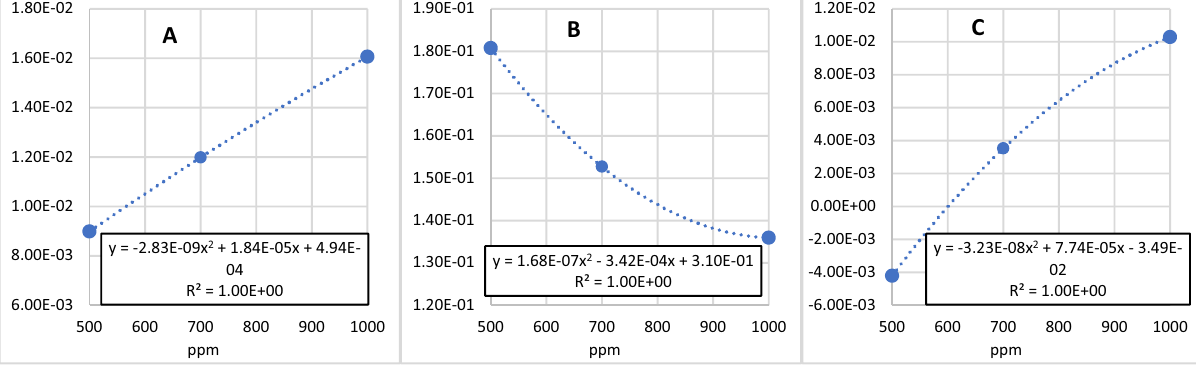
Fig. 14 Relation between the parameters A , B and C of Eq. 8 and the concentration of HPAM. Variable x in equations corresponds to the hori- zontal axis